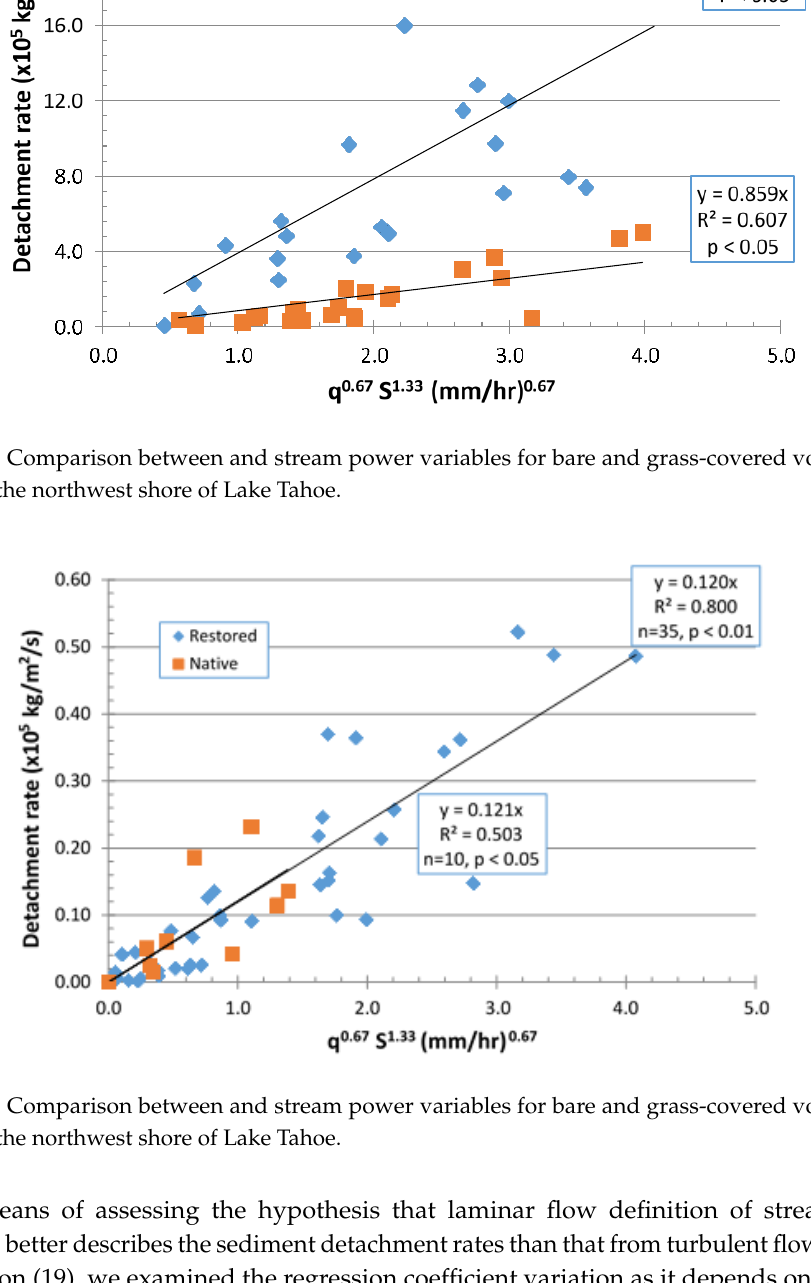
Figure 6. Comparison between and stream power variables for granitic RS plots on the southwest shore of Lake Tahoe.